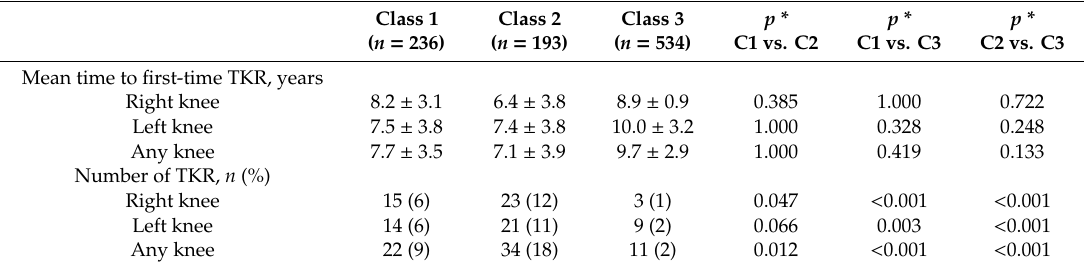
Table 2. Details of first-time total knee replacement across three pain phenotypes.